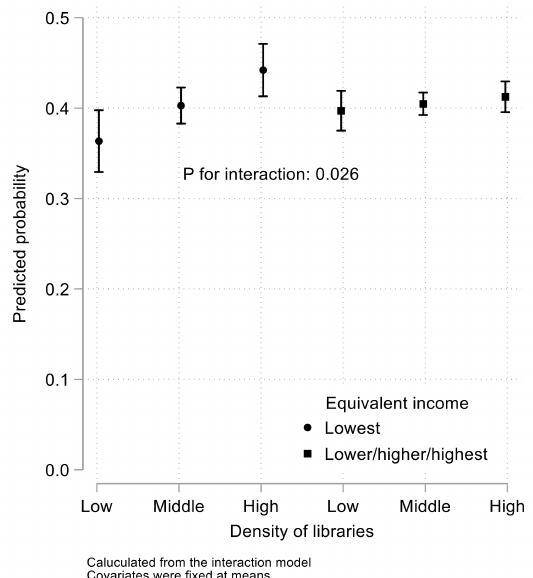
Figure 3. Predicted probability by a model with an interaction